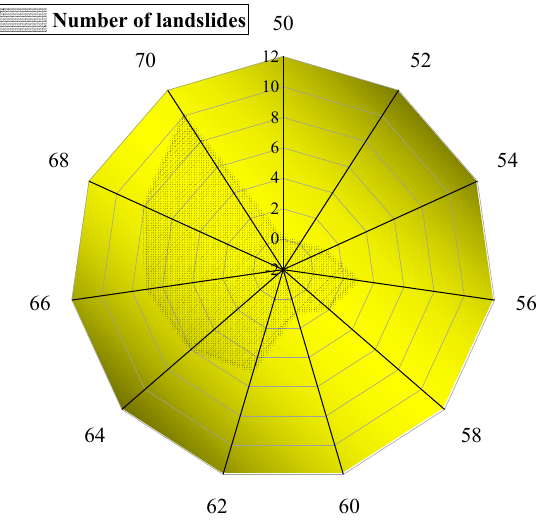
Figure 17. Number of field landslides with different α (survey up to July 2019).